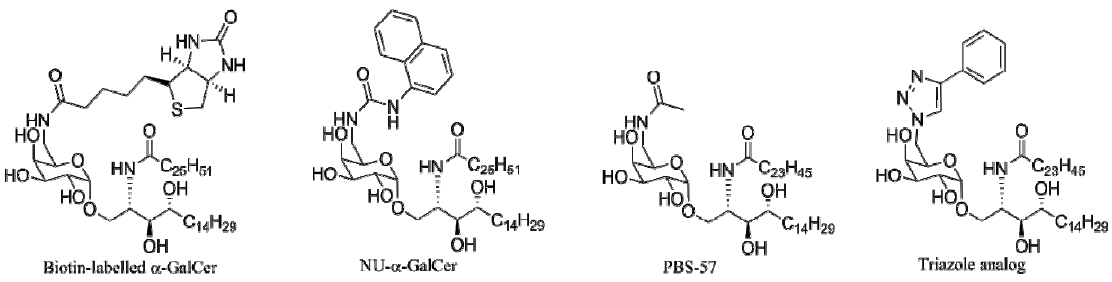
Figure 7. 6"- α -GalCer analogs for iNKT